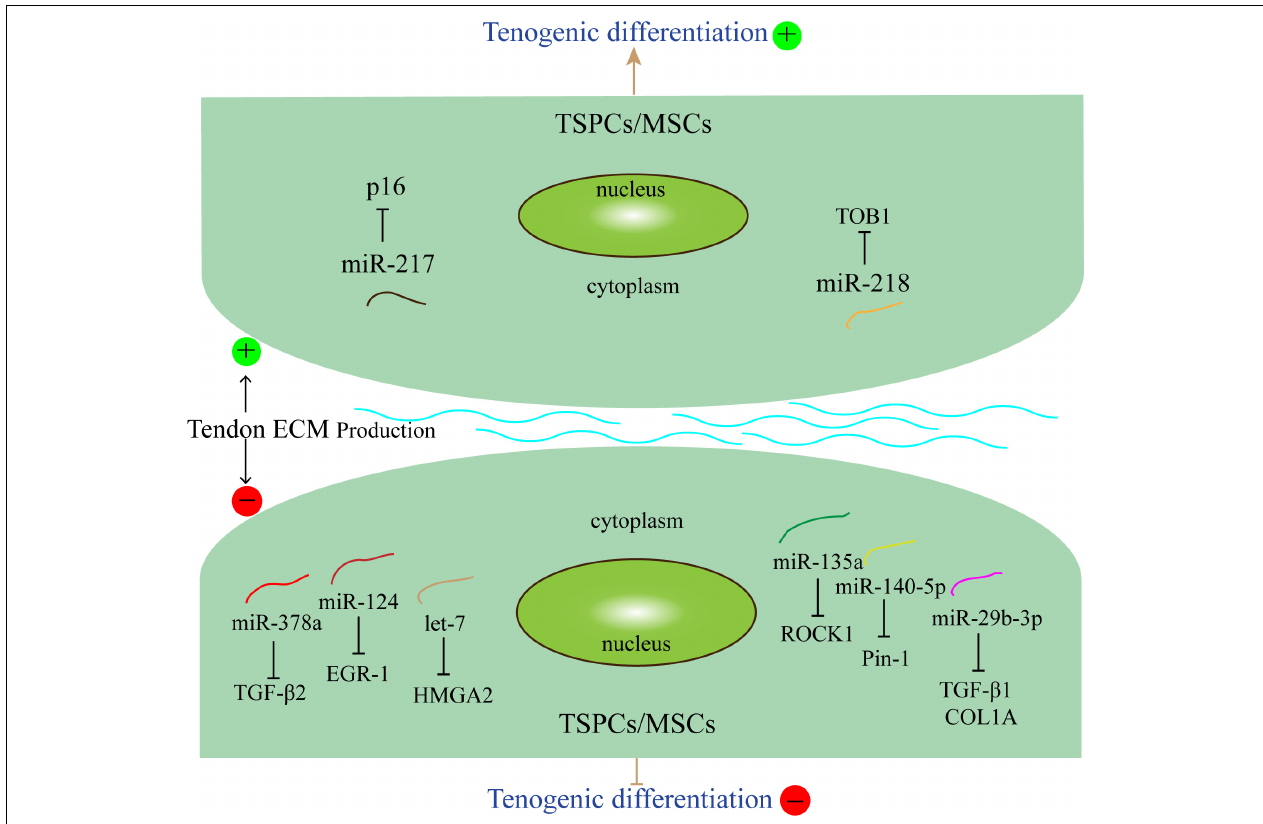
FIGURE 1 | miRNAs related to tenogenic differentiation. Several miRNAs, such as miR-140-5p, miR-29b-3p, miR-378a, miR124, let-7, and miR-135a could inhibit tenogenic differentiation. Other miRNAs, including miR-217 and miR-218 could promote tenogenic differentiation. The arrows and T-shaped lines point toward mechanisms that represent promotion and inhibition,